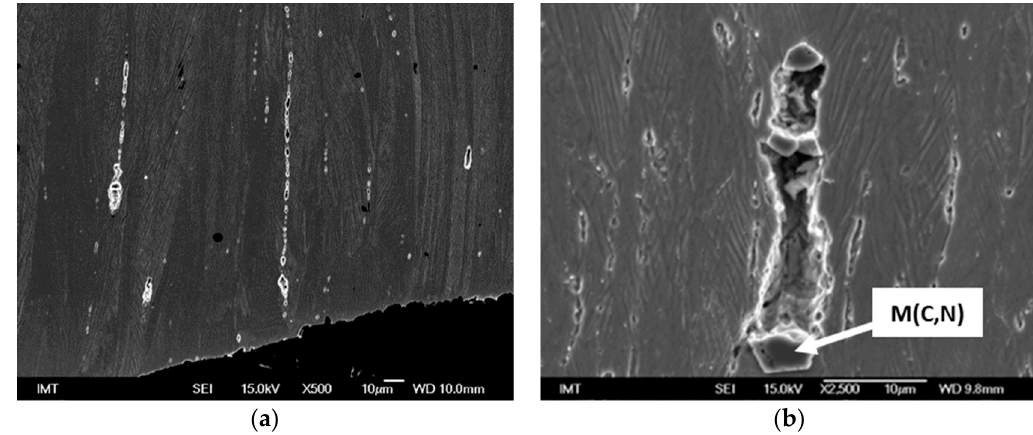
Figure 19. The fracture surface of the samples hot rolled at 1050 ◦ C with the deformation level of 23.5% and aged at 750 ◦ C for 125 h ( a , b ). The fracture surface of sample hot rolled at 1050 ◦ C with the deformation level of 12.7% and aged at 750 ◦ C for 125 h ( c , d ).